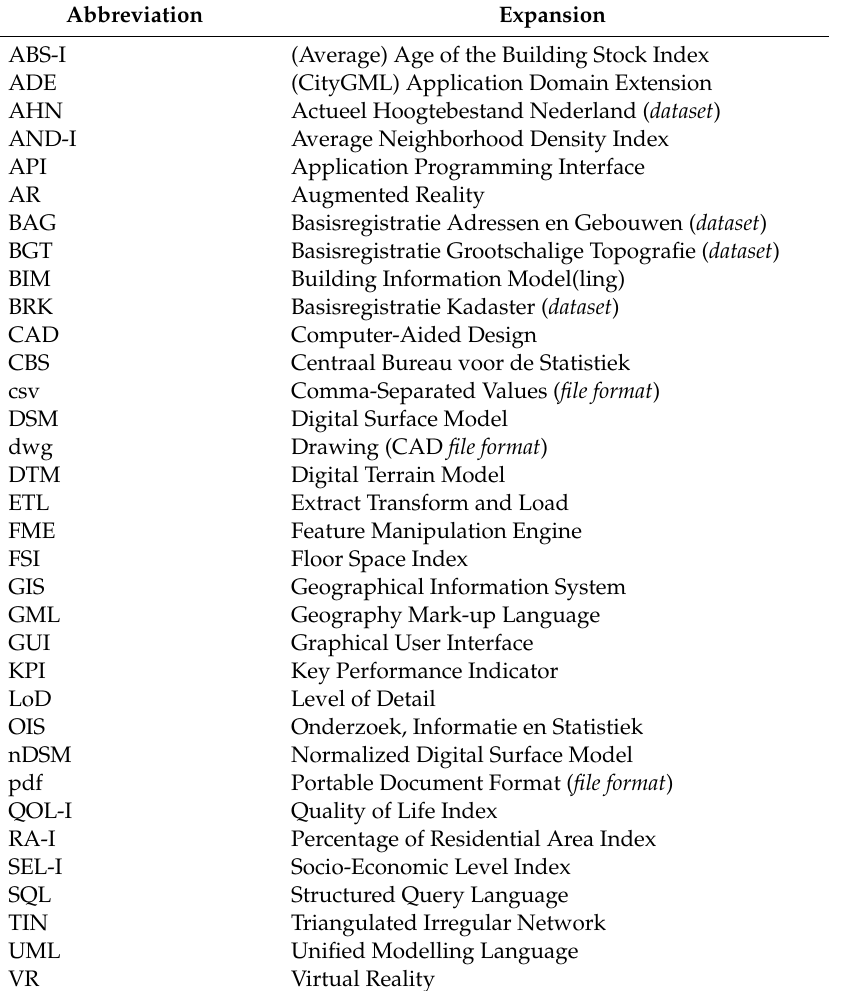
Table A1. List of